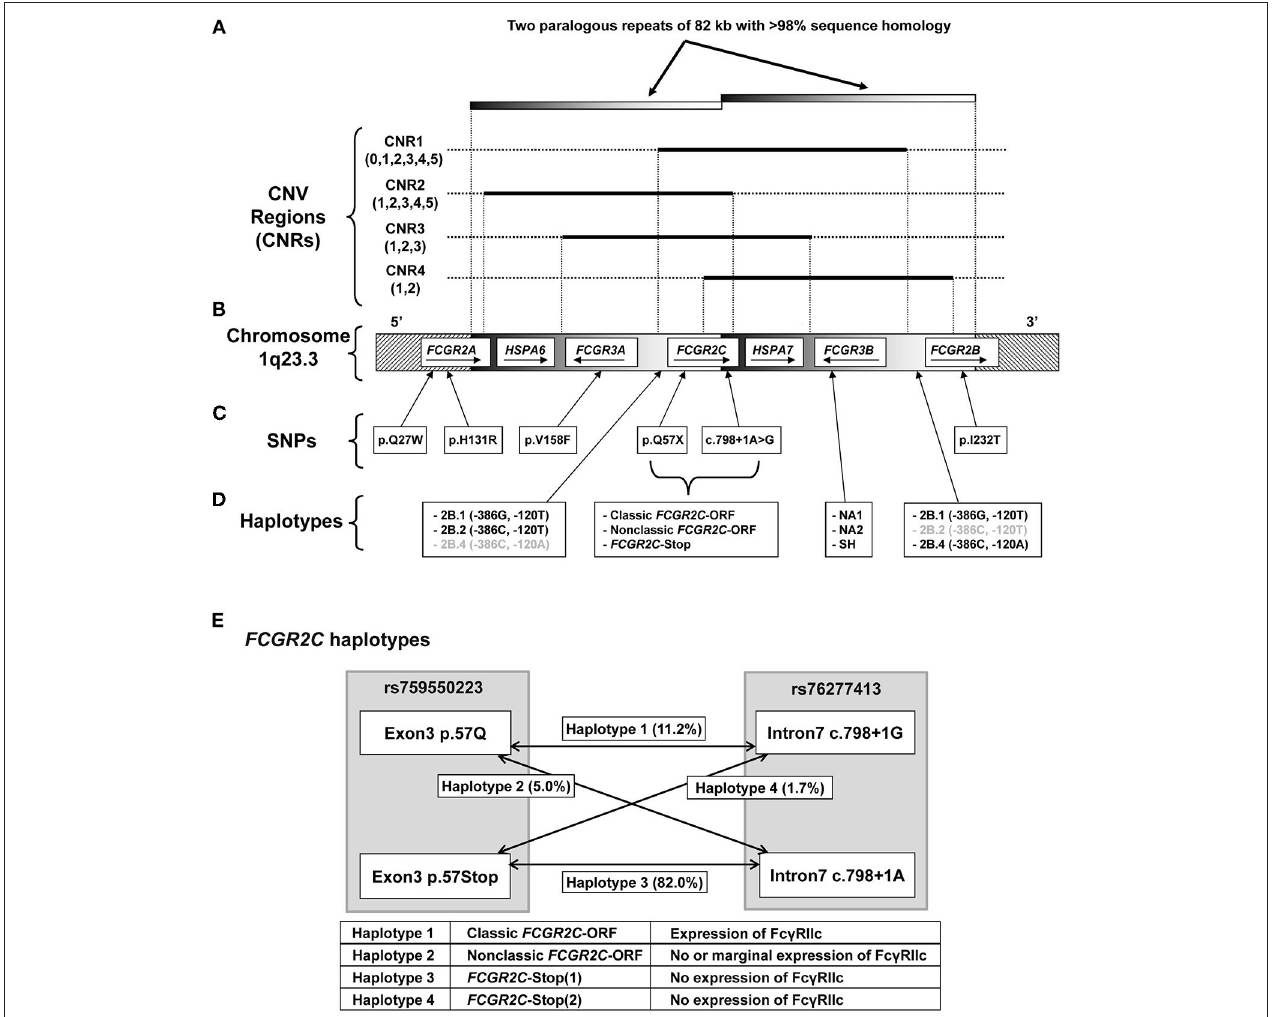
FIGURE 1 | Genomic organization of the FCGR2/3 locus. Overview of the FCGR2/3 locus at 1q23.3. (A) CNV at the locus occurs always in regions containing a series of genes, termed CNV regions (CNRs) ( 18, 21). Numbers between brackets indicate observed copy number for that CNR in the individuals tested in this study, black lines indicate the extent of the different CNRs. Gray shaded bars indicate the extent of two paralogous repeats of the locus. The novel rare CNR4 that we recently described ( 18) was found in 4 of the individuals included in this study, and was combined with the similar CNR1 in this study for reasons of simplicity. (B) Overview of the genes in the locus with their orientation. Depiction of genes is not to scale. (C) Functional SNPs at the locus, indicated by single letter amino acid code and amino acid position, except for the splice variant c.798 + 1A > G. All these SNPs were determined in this study. (D) Functional haplotypes at the locus. 2B.1, 2B.2, and 2B.4 are haplotypes of two SNPs (at nucleotide positions − 386 and − 120 relative to the start of translation) in the otherwise identical promoter regions of FCGR2B and FCGR2C (haplotypes in gray are very rarely found in that particular gene). FCGR3B NA1, NA2, and SH are haplotypes determined by six SNPs.